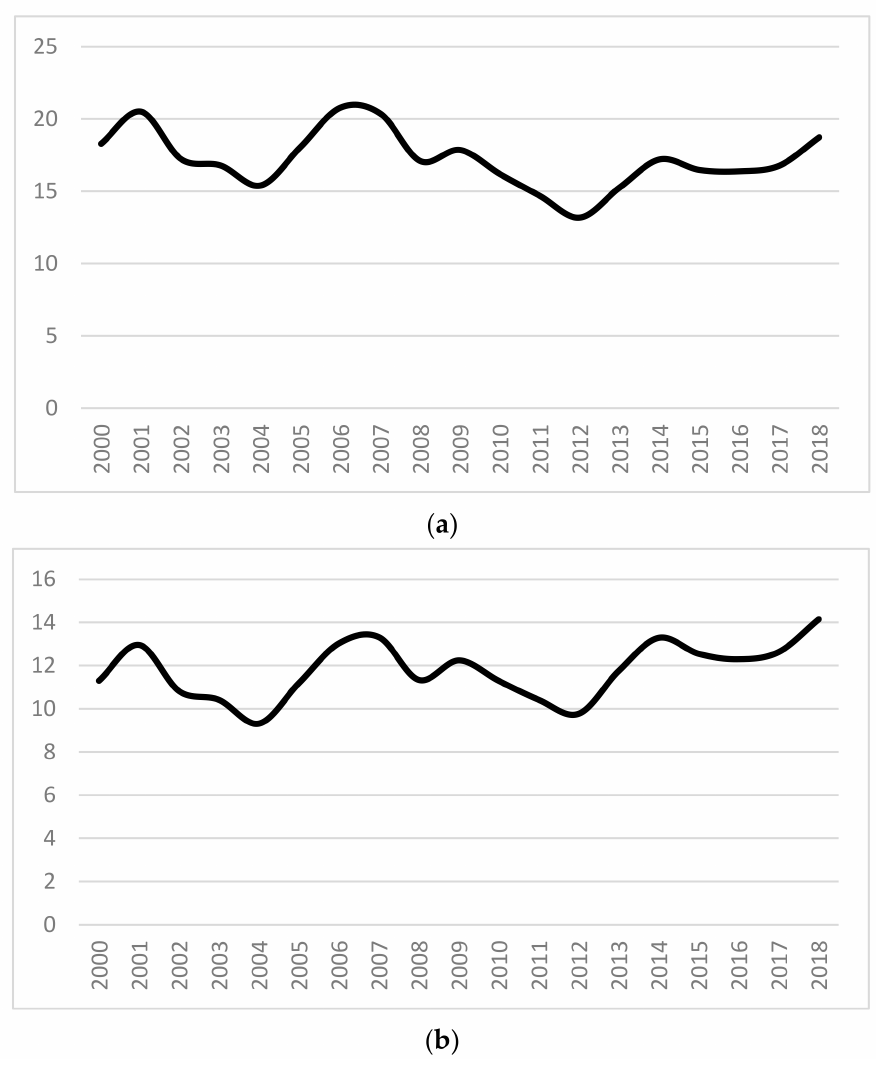
Figure 1. σ -convergence analysis. ( a ) Standard deviation. ( b ) Coefficient of